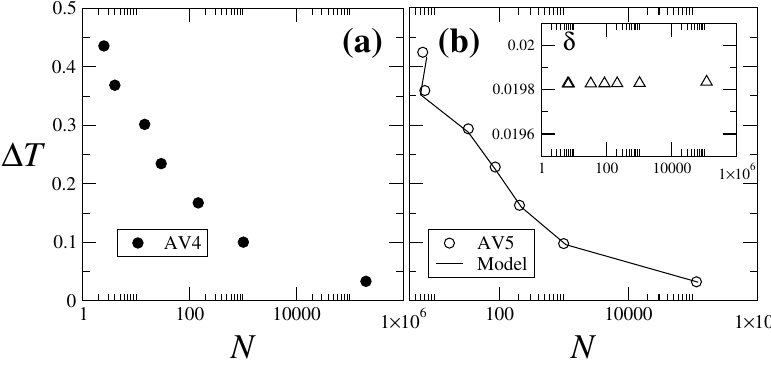
Figure 8. Rain flow counting (RFC) of the load (torque) series at ( a ) AV4 (the dataset used for deriving the drift and diffusion of the torque model plotted in Figure 5) and ( b ) AV5. While the measurements at AV4 were used for deriving the Langevin model, for AV5, one uses the derived model for reconstructing the data and compares the estimated loads with the observed ones. In the inset, we show the relative deviation η from Equation (9) of the estimate with respect to the experimental results.